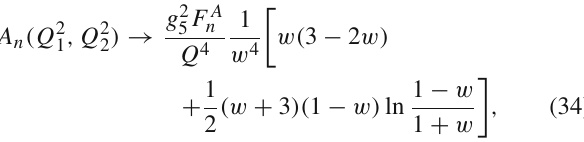
Fig. 6 Axial-vectorcontributionto Q 2 Q 2 ¯ (cid:7) 1 ( Q , Q , Q 3 ) asafunction 3 of Q 3 at Q = 50 GeV in the HW2 model normalized to the asymptotic /( 2 π) 2 set to one). The black line corre- value (36) (with prefactor g 2 5 sponds to the infinite sum over the tower of axial vector mesons, and the other lines give the contributions of the 1st to 5th lightest axial vector mesons. (Figure taken from